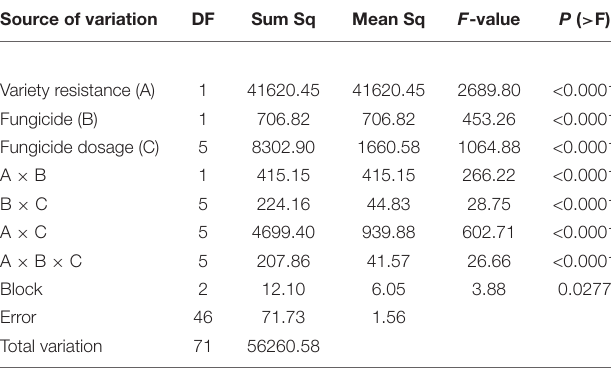
TABLE 5 | Multiple factor analysis of mildew under different active ingredient dosages of two fungicides on two varieties in 2019/20